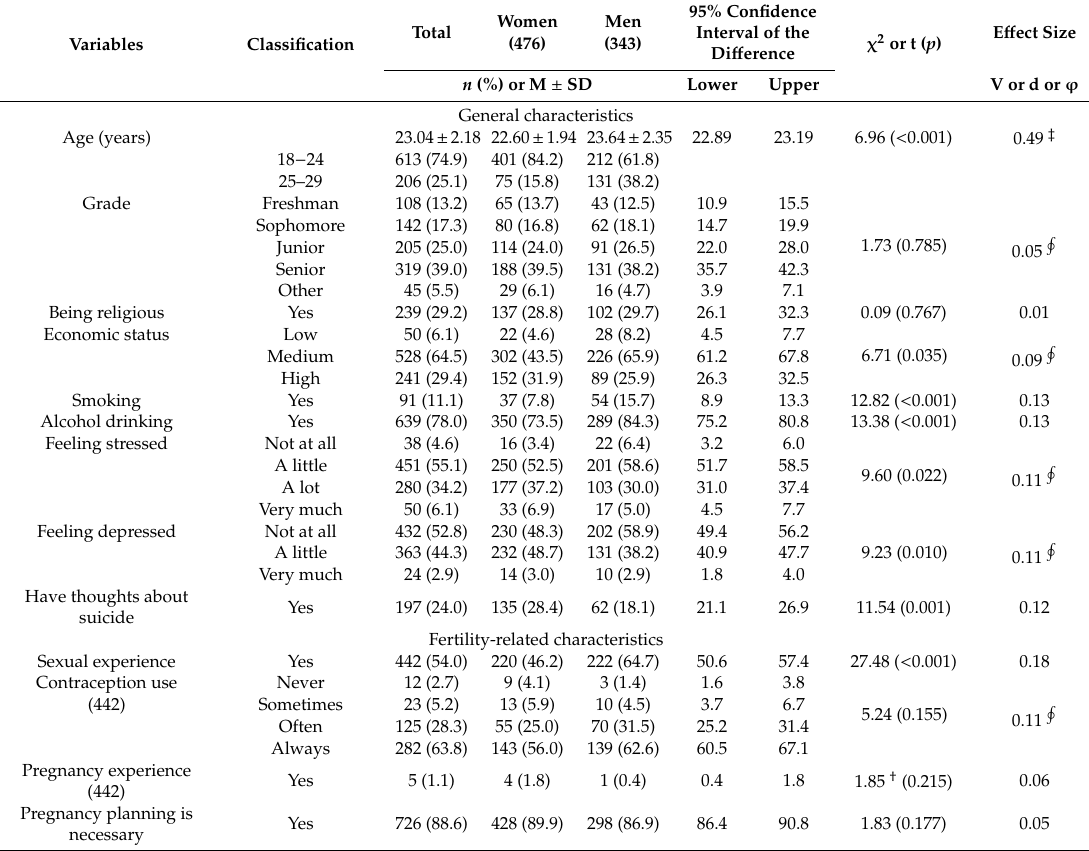
Table 1. General and fertility-related characteristics by gender ( n =